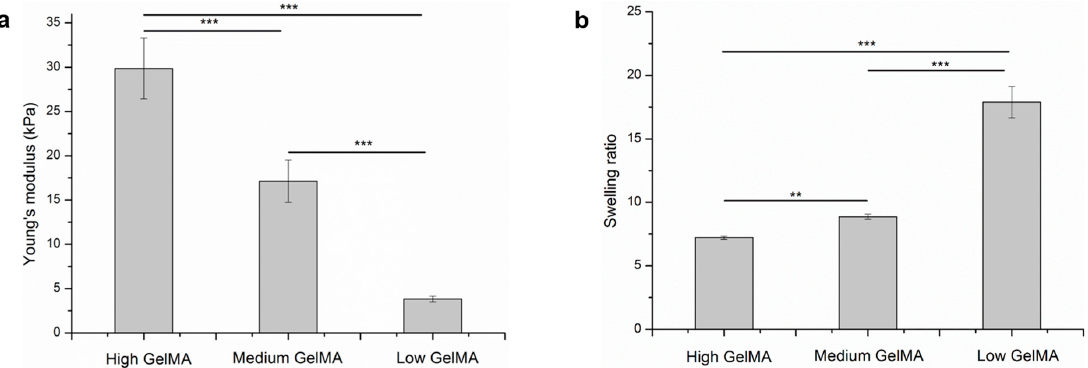
Figure 3. Young’s modulus ( a ) and equilibrium swelling ratio ( b ) of GelMA hydrogels with high, medium, and low stiffness. Means ± SD, n = 3. *** p < 0.001; ** p < 0.01.